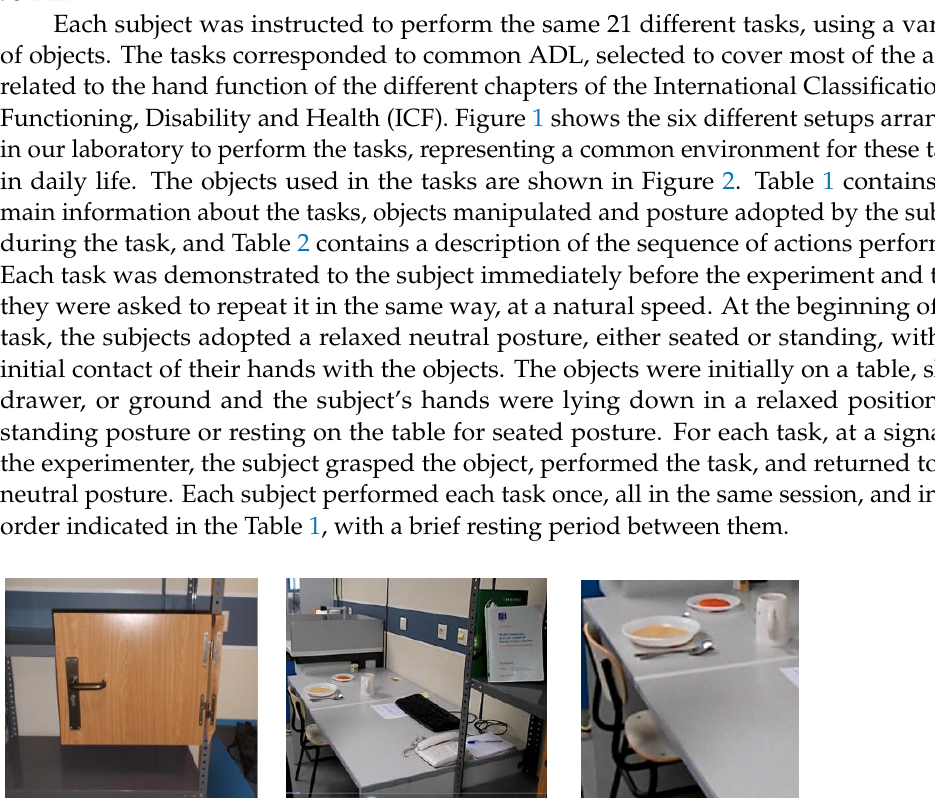
Figure 2. Objects used in the tasks: ( a ) key, ( b ) book, ( c ) pen, ( d ) phone, ( e ) keyboard, ( f ) bottle, ( g ) spoon, knife, fork, ( h ) glass, ( i ) toothbrush, ( j ) toothpaste tube, ( k ) comb, ( l ) pistol grip sprayer, ( m ) cleaning cloth, ( n ) aerosol can, ( o ) iron, ( p ) briefcase.